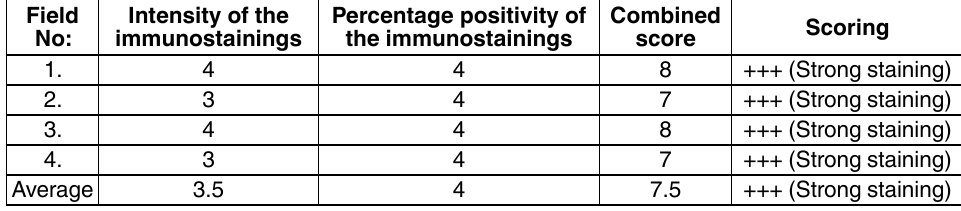
table 4. Combined score for Immunostaining of granulosa cells